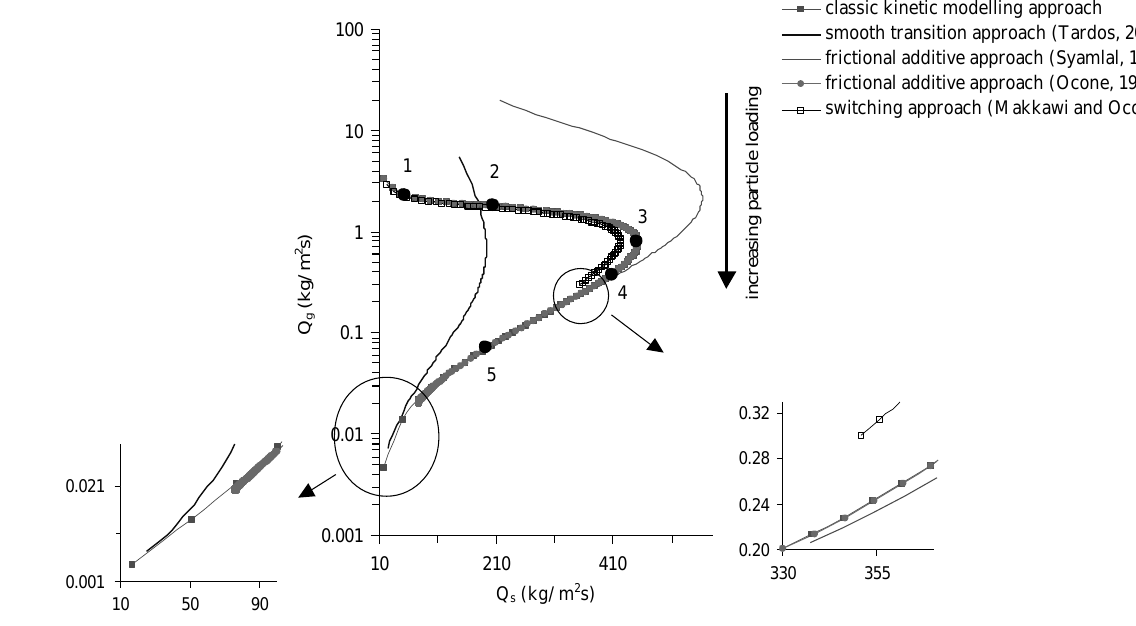
Fig. 7 Gas-solid flow map predicted by various modelling